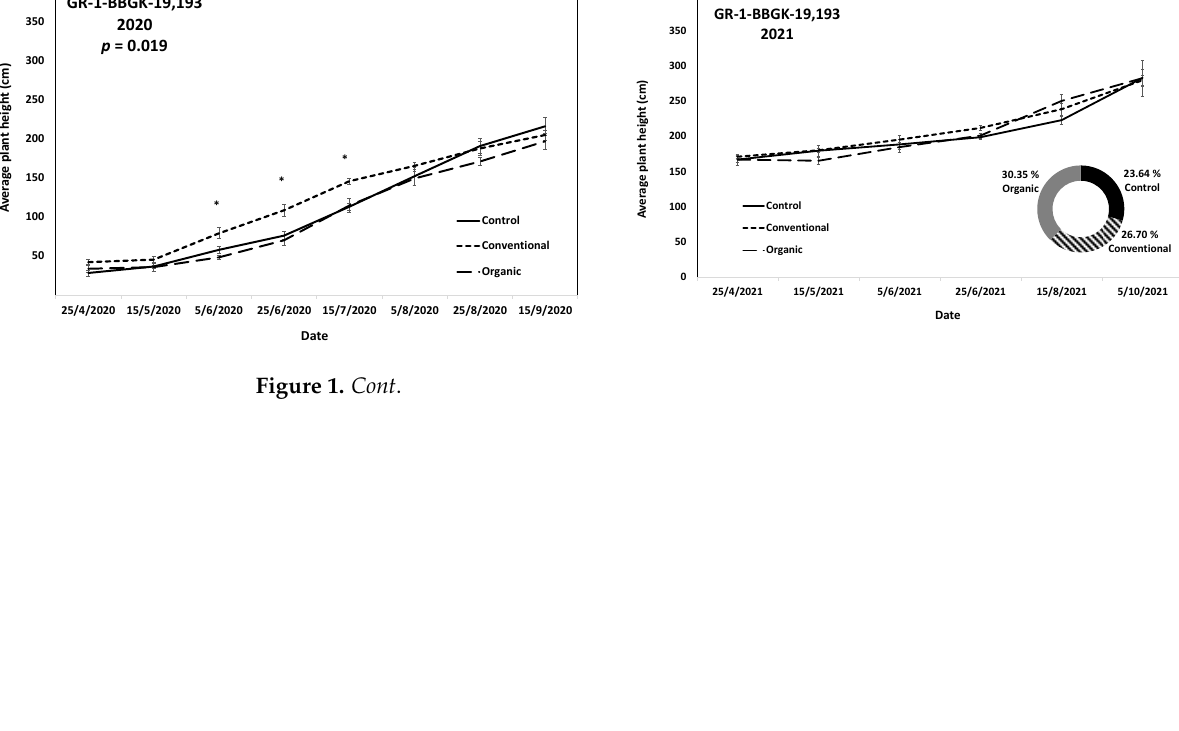
Figure 1. Plant growth pa tt erns expressed as average plant height (cm) for Rosa canina genotypes GR-1-BBGK-19,193, GR-1-BBGK-19,191, GR-1-BBGK-19,635, and GR-1-BBGK-19,674 during the fi rst two years of the pilot fi eld trial (2020 and 2021) for the three fertilization treatments applied (control, conventional, and organic). Standard errors of the means are shown on the graphs ( p < 0.05). The treatment e ff ects over time (within-subjects e ff ects) were assessed via a Repeated Measures ANOVA separately for each genotype and year and were found signi fi cant in all cases ( p < 0.05). In cases